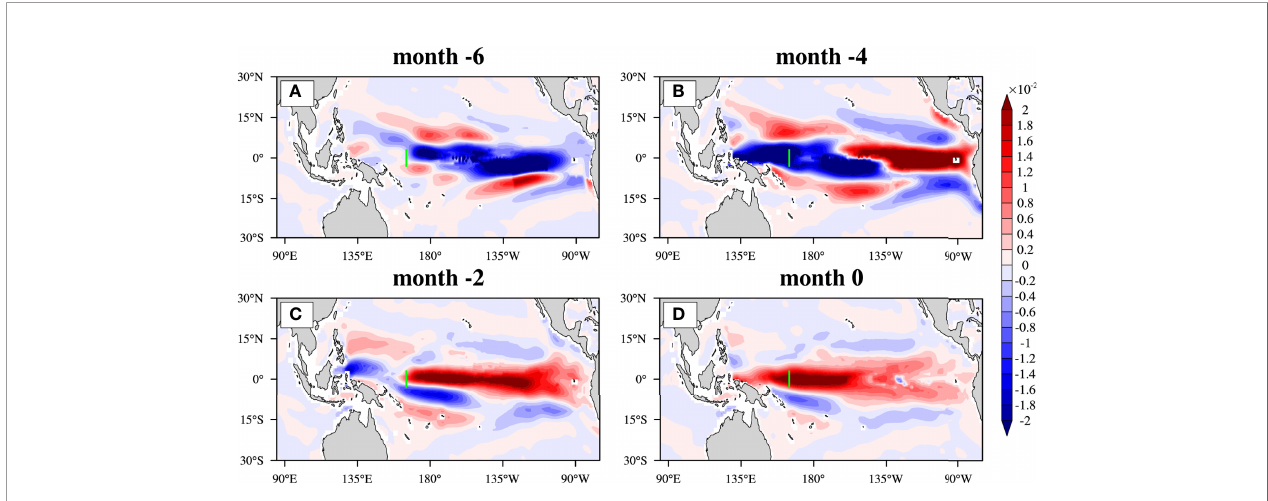
FIGURE 7 | Same as Figure 6 but due to the sensitivity-like wind velocity perturbation at month -6 and (A – D) represent different previous